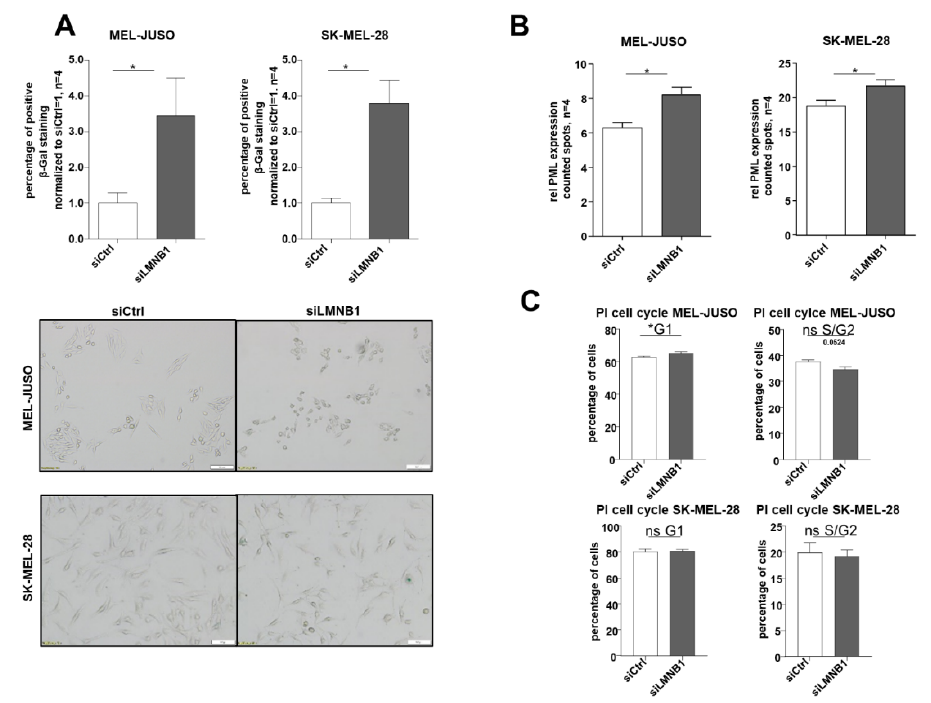
Figure 2. ( A ) SA β -galactosidase staining of MEL-JUSO and SK-MEL-28 transfected with siLMNB1 (72 h) as senescence detection (Student’s t -test). ( B ) Immunofluorescence staining of the promyelocytic leukemia protein (PML) expression in MEL-JUSO and SK-MEL-28 transfected with siLMNB1 and siCtrl for 72 h as senescence detection (Student’s t -test). ( C ) Flow cytometry with the fluorescent dye propidium iodide for cell cycle staining. MEL-JUSO and SK-MEL-28 treated with siLMNB1 and siCtrl for 72 h (Student’s t -test). Bars represent the means ± SEM (* = p ≤ 0.05, ns = not